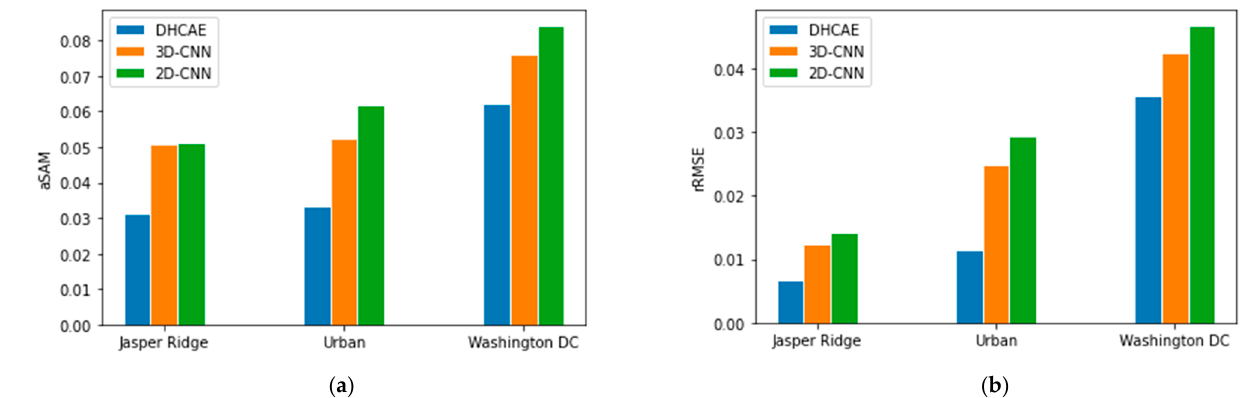
Figure 17. Comparison between DHCAE and other methods. ( a ) aSAM. ( b ) rRMSE.